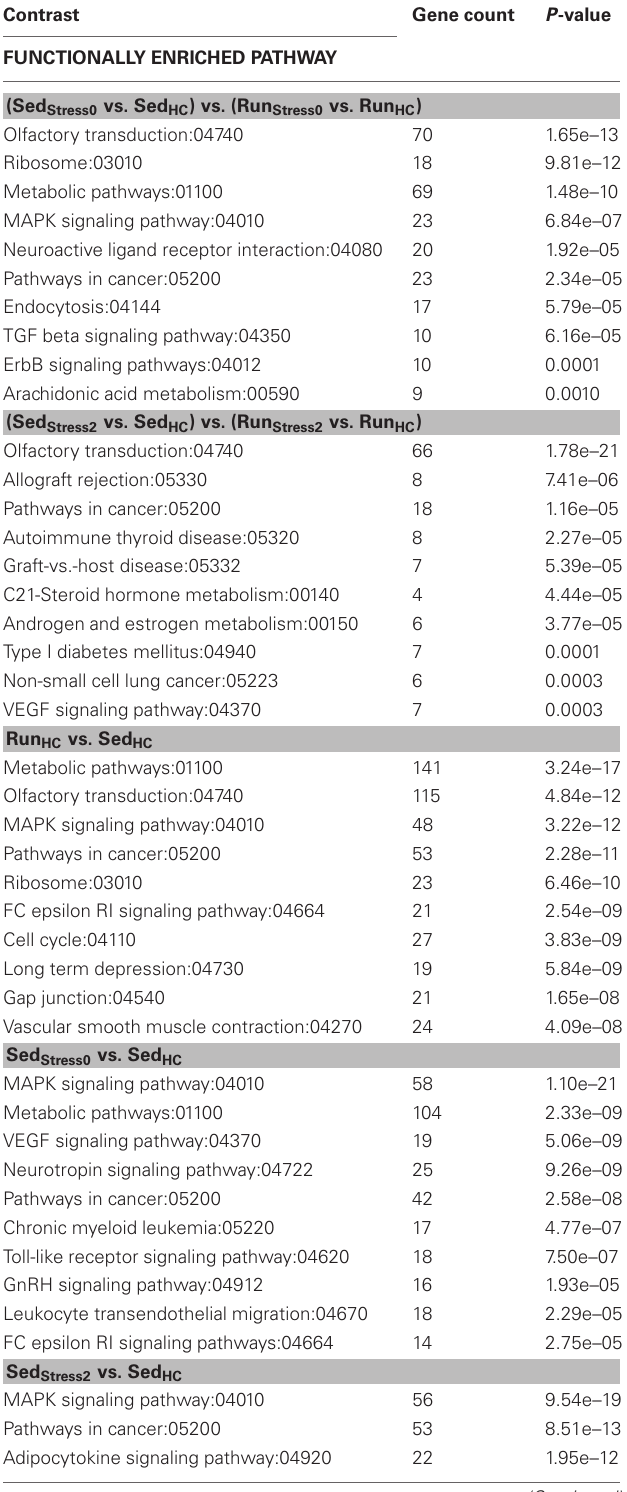
Table 1 | KEGG functionally enriched pathway categories generated from genes significantly differentially expressed at p < 0 . 05 in the DRN in response to exercise and/or